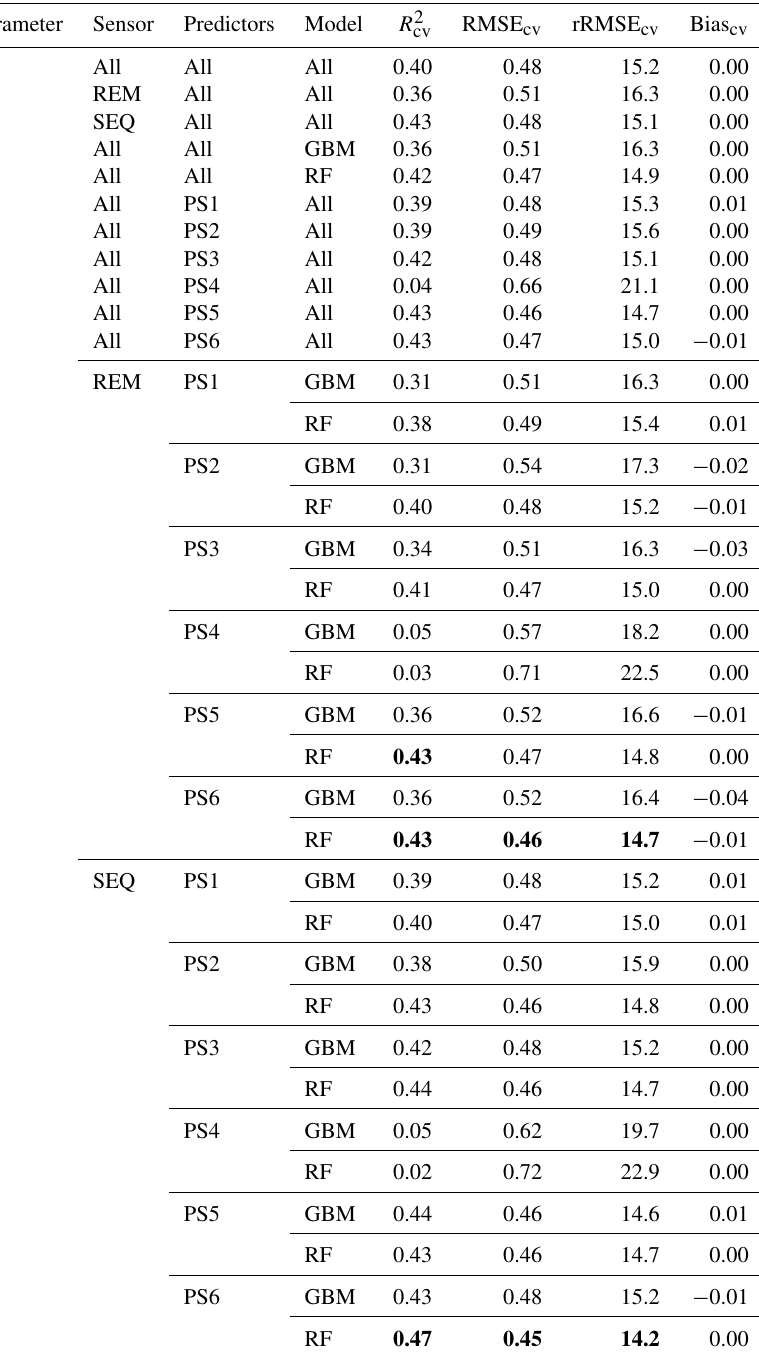
Table 5. Overview of the plant N concentration models and cross-validation evaluation metrics for all combinations of sensors (REM, SEQ), predictor sets (PS1: raw reflectance data, PS2: VI, PS3: raw reflectance data + VI, PS4: canopy height, PS5: raw reflectance data + canopy height, PS6: raw reflectance data + VI + canopy height), and ML algorithms (GBM, RF). The unit of RMSE cv and absolute Bias cv is weight percent. All metric values of single-sensor–predictor set–algorithm combinations are averages of the 10 iterations. Best results per sensor in bold. The first 11 rows per parameter show aggregated median results (e.g. median of all DM models). N obs =